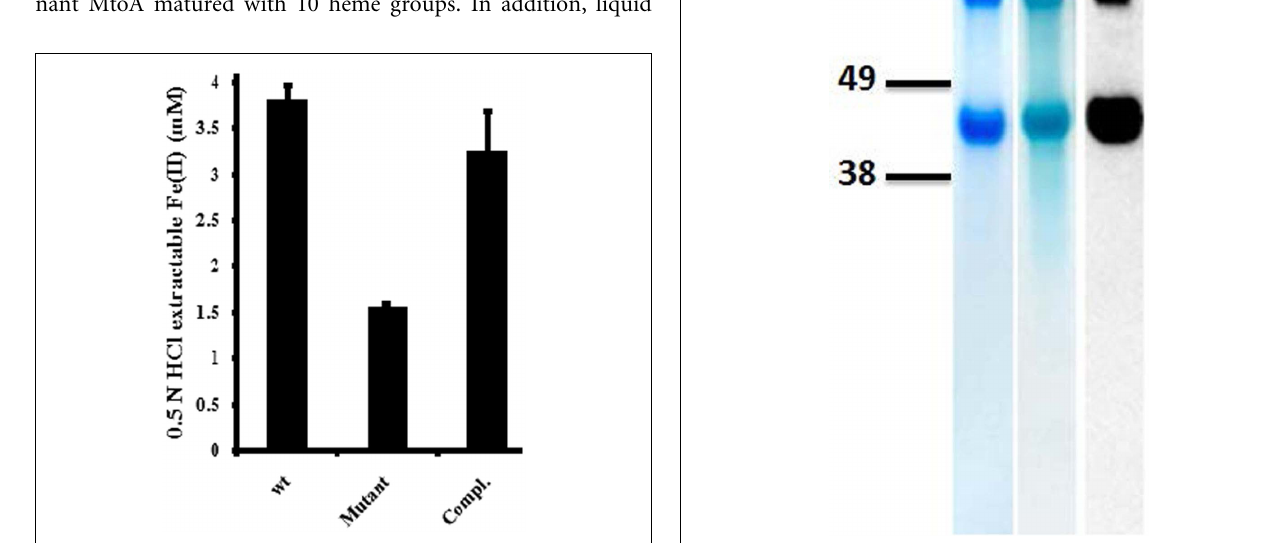
FIGURE 3 | Purification of MtoA. A total of 2 μ g of isolated MtoA was run by SDS-PAGE and then visualized by GelCode staining (lane A) and heme staining (lane B) or probed with RGS-His-HRP antibody (lane C). Migration positions of protein standards with different molecular masses (kDa) are indicated at the